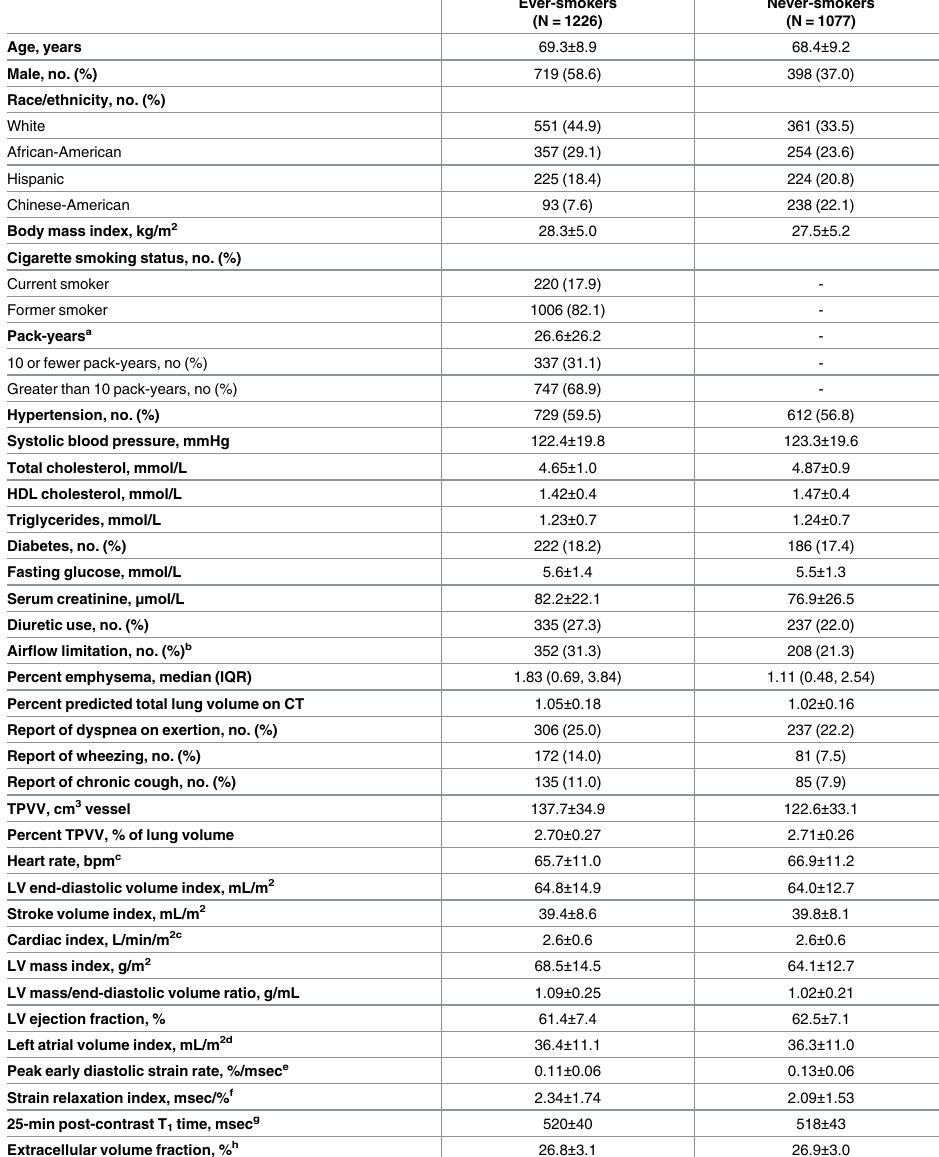
Table 1. Characteristics of MESA lung participants with measurement of LV on cardiac MRI and total pulmonary